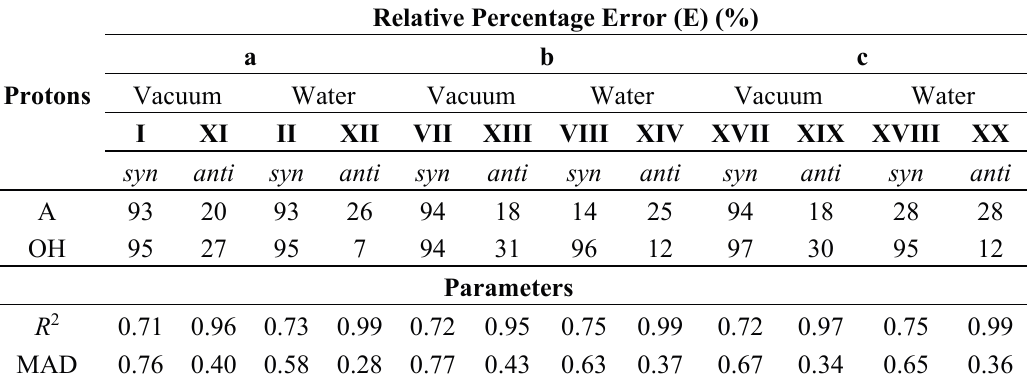
Table 5. Calculated relative percentage errors (E) of protons A and OH of losartan anion ( 1 ) rotamers recorded at 293 K and values of coefficient of determination ( R 2 ) and mean absolute deviation (MAD) parameters as a factor describing the correlation of 1 H-NMR with experimental data; the following approaches were considered: (a)